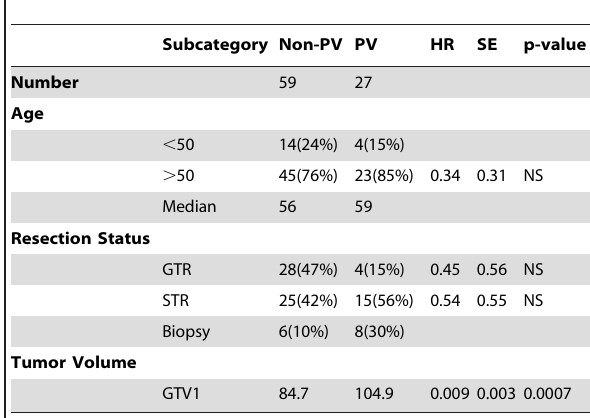
and patients with the largest tumors in the top quartile (Q4), based on GTV1 volumes. Median OS for patients with the smallest